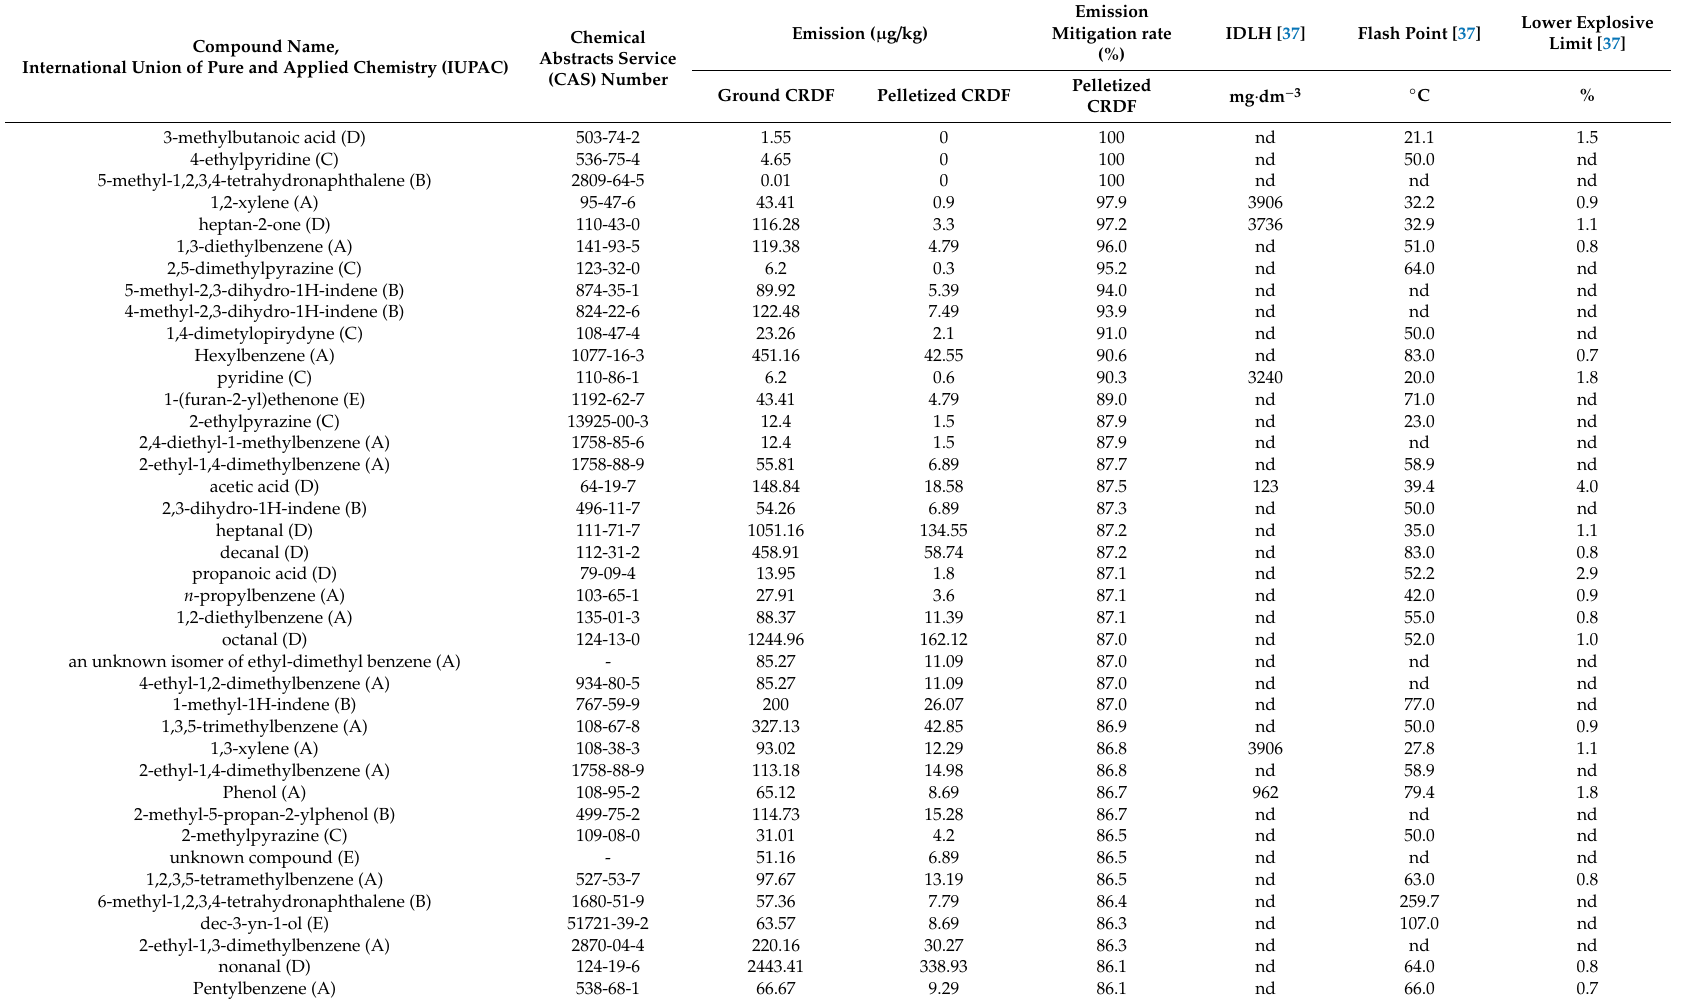
Table 1. VOCs emitted from torrefied carbonized refuse-derived fuel (CRDF): ground and